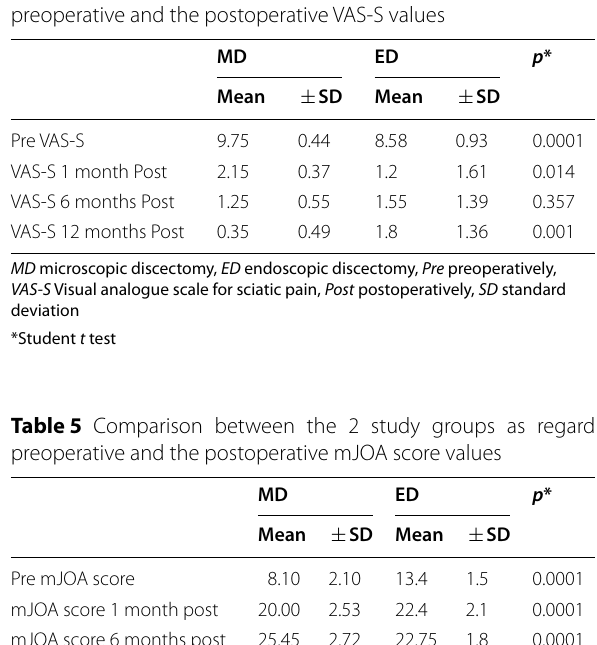
Table 4 Comparison between the 2 study groups regarding the